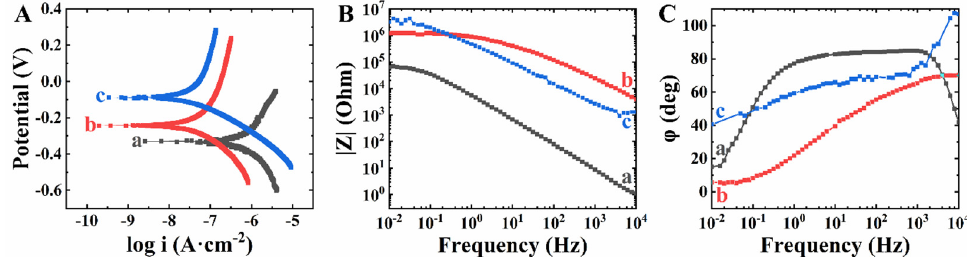
Figure 2. ( A ) Tafel and ( B , C ) Bode plots for (a) uncoated and (b,c) coated substrate: (b) as-deposited coatings and (c) coatings annealed at 200 °C for 1 h, prepared from 20 g L − 1 PEMA solutions.